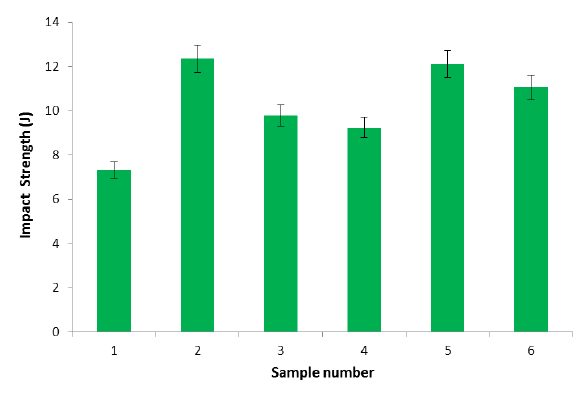
Figure 10: Vickers hardness for all